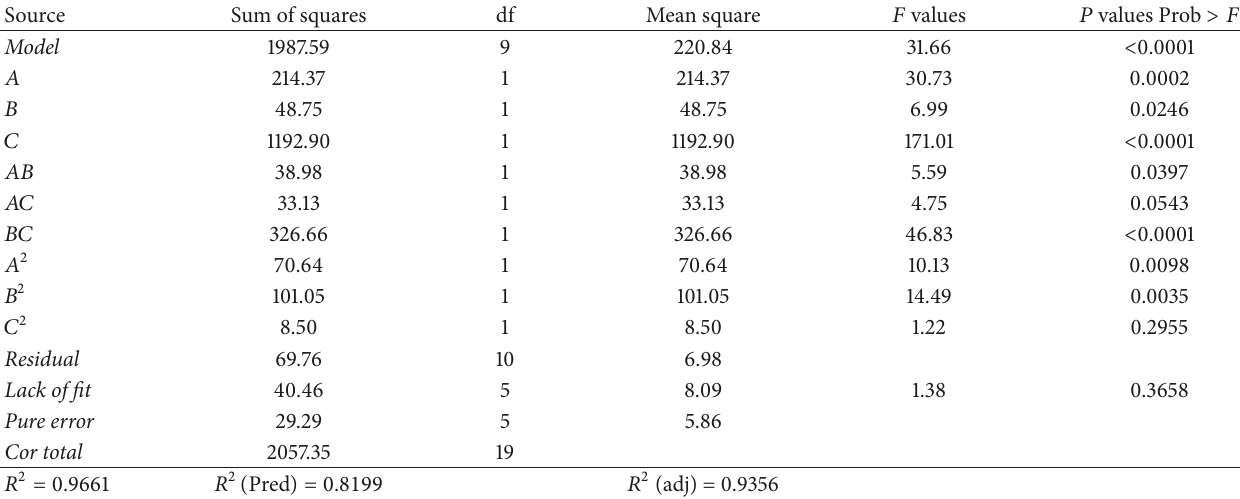
Table 3: ANOVA for response surface reduced quadratic model for USA